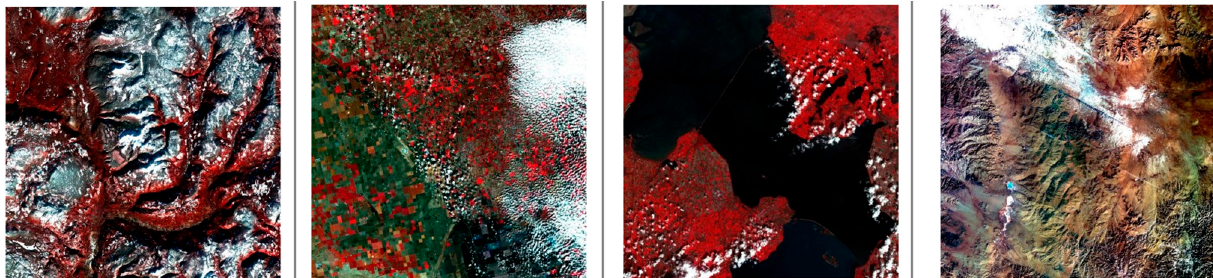
Figure 3. Example graph of a data set.